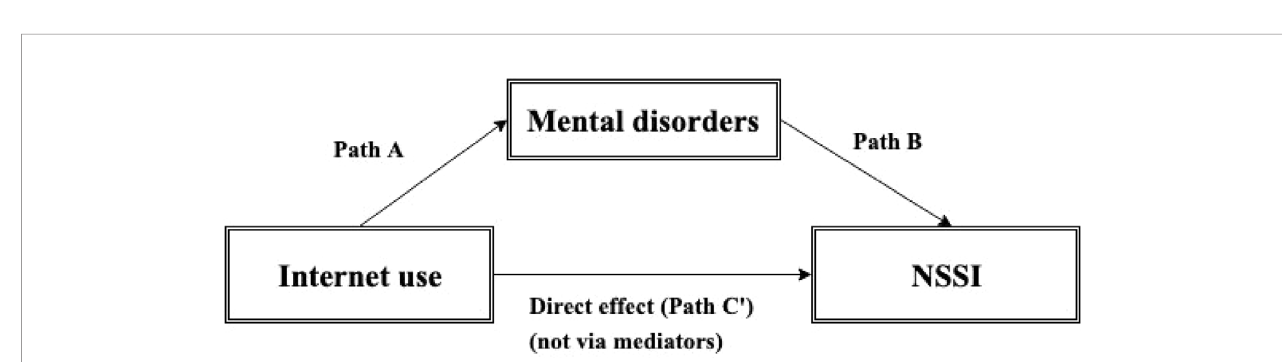
FIGURE 1 | Mediation model. Path A, path B, the direct pathway/effect between internet use and NSSI (C ′ ), and indirect pathway/effect via mediating factors (Path A * Path B). Path A: The effect of the symptoms of internet use on comorbid mental disorders. Path B: The effect of the comorbid mental disorders on prevalence of NSSI.